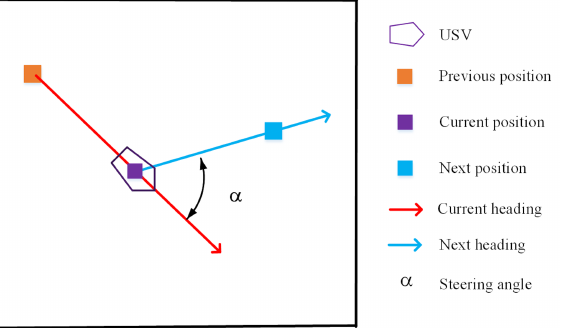
Figure 2. USV heading and steering